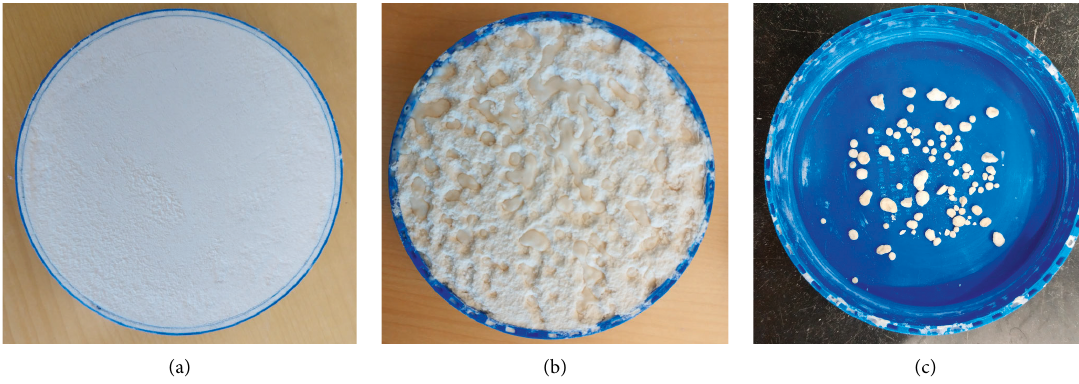
Figure 5: (a) Flour cup, (b) flour cup exposed to rainfall, and (c) flour pellets after oven